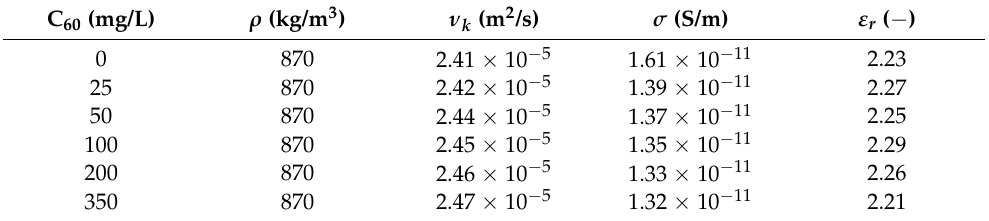
Table 2. Properties of C 60 fullerene doped aged Trafo En mineral oil (20 ◦ C).